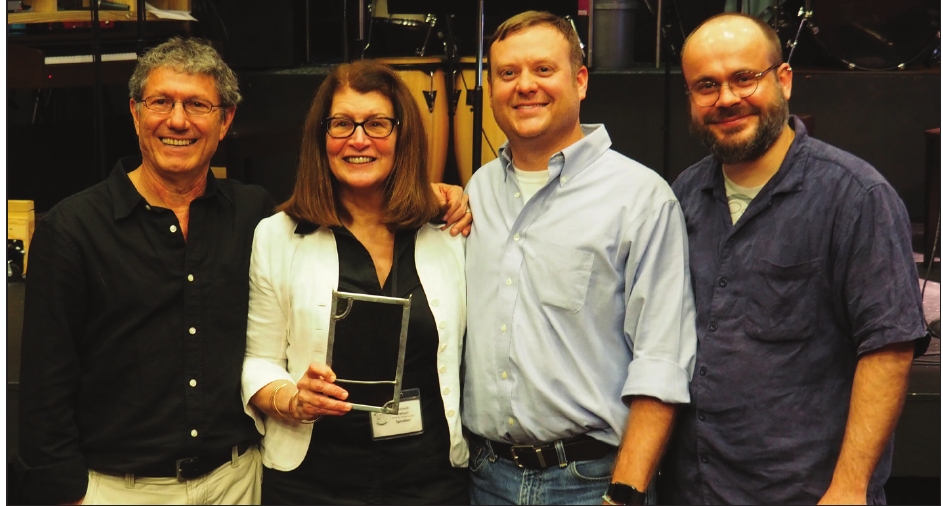
Figure 3: Elizabeth Graham with (l to r) Jaime Awe, former Director, Belize Institute of Archae- ology, now N. Arizona University; Mat Saunders, Maya-at-the-Lago convenor; Christophe Helmke, University of Copenhagen (Photo American Foreign Academic